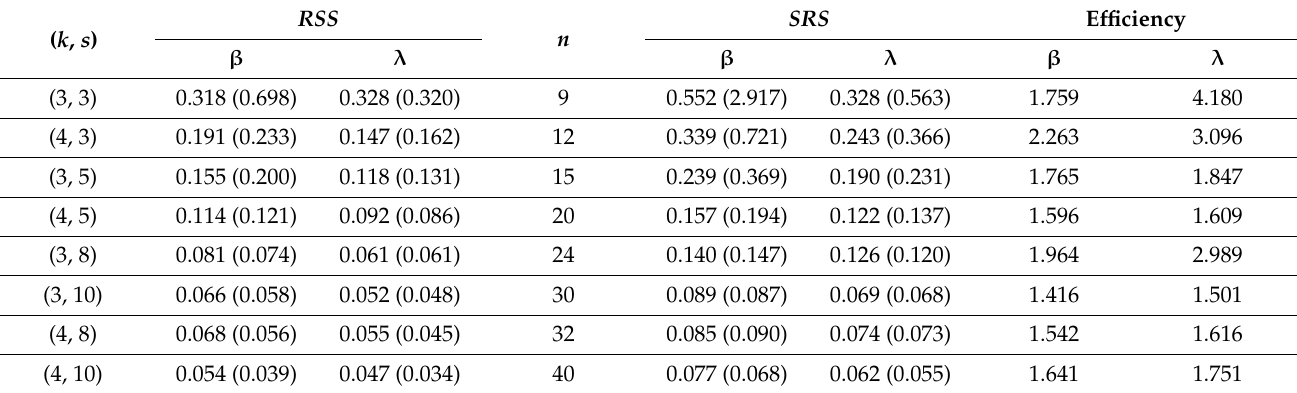
Table 2. The bias ( MSE ) and efficiency of the MLE parameters β and λ when β = 1 and λ = 1.